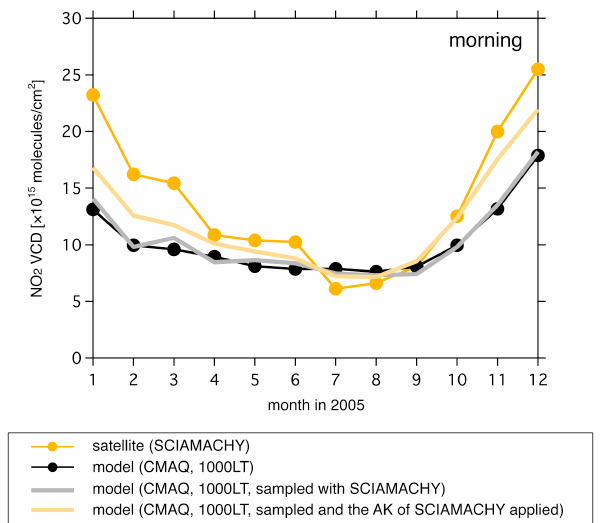
Fig. 2. Modeling reproducibility of monthly mean tropospheric NO 2 VCD above central eastern China (CEC) in 2005. Model results are shown for three data sets: simply selected at 10:00LT (black line), sampled with valid pixels of the SCIAMACHY data (gray line), and sampled with valid pixels and besides the averaging kernel (AK) information of the SCIAMACHY data applied (light-orange